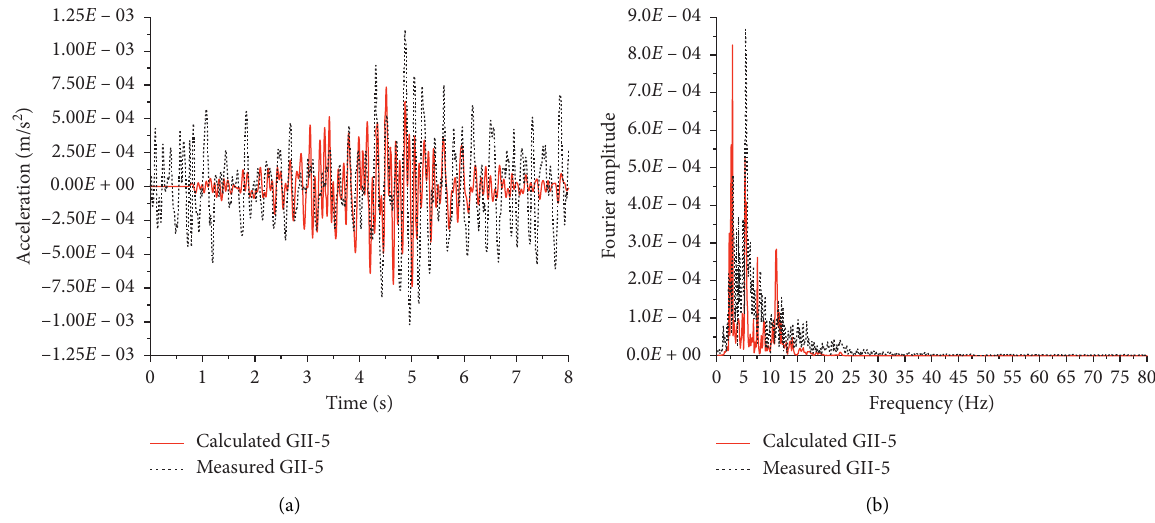
Figure 20: Comparison of numerical and field results (GII-5): (a) acceleration time history; (b) frequency spectrum.